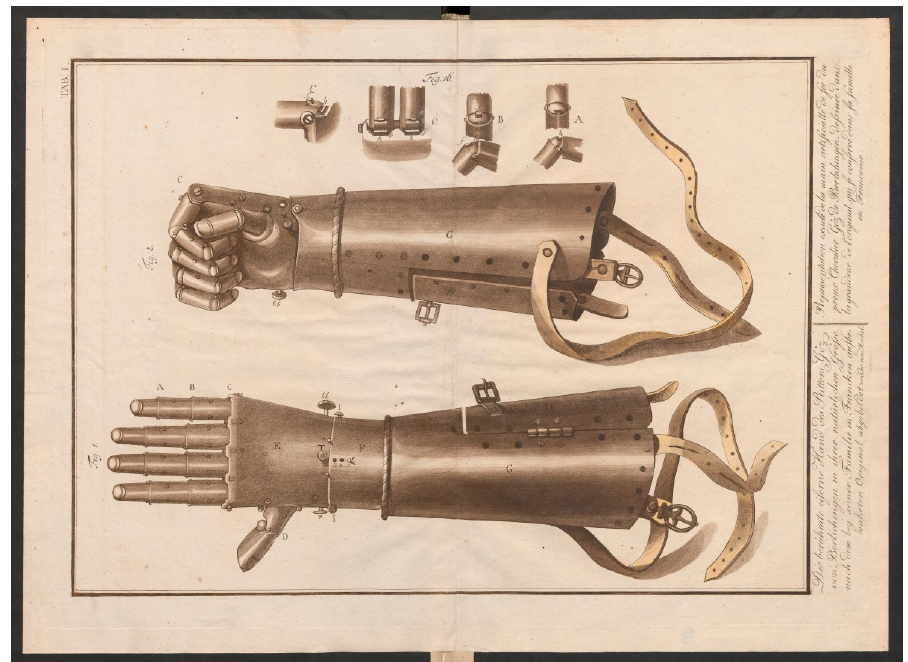
Figure 1. Götz von Berlichingen´s second “Iron Hand”, external hand and forend: two-piece, round, slightly conical bracer (forend) for attaching the prosthesis to the forearm. Hinged flap closed with two leather straps and buckles. Four individual fingers movable in three joints, thumb movable in only one joint (the base joint of the thumb is firmly connected to the body of the hand). Two buttons were used to return the thumb or the four remaining fingers to the normal position (open hand) by spring force.